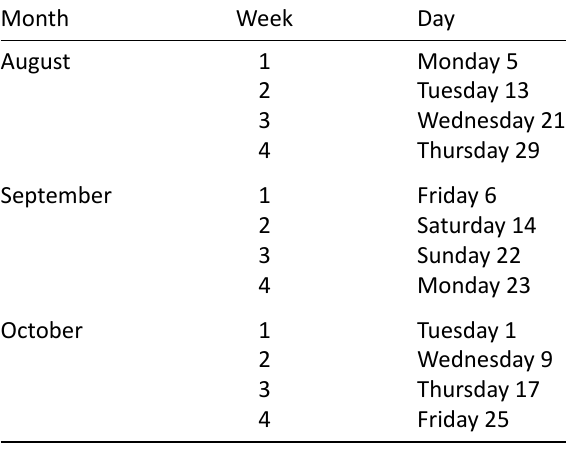
Table 3. Sampling